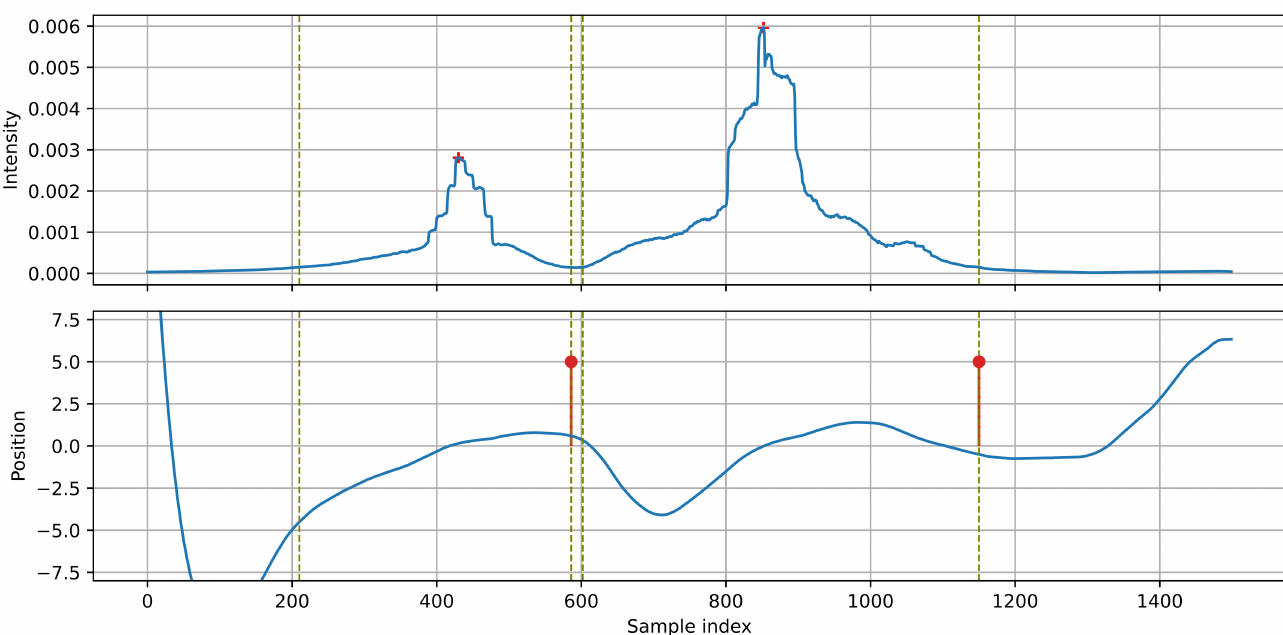
Figure 10. Example of an unsuccessful detection: the third vehicle is not